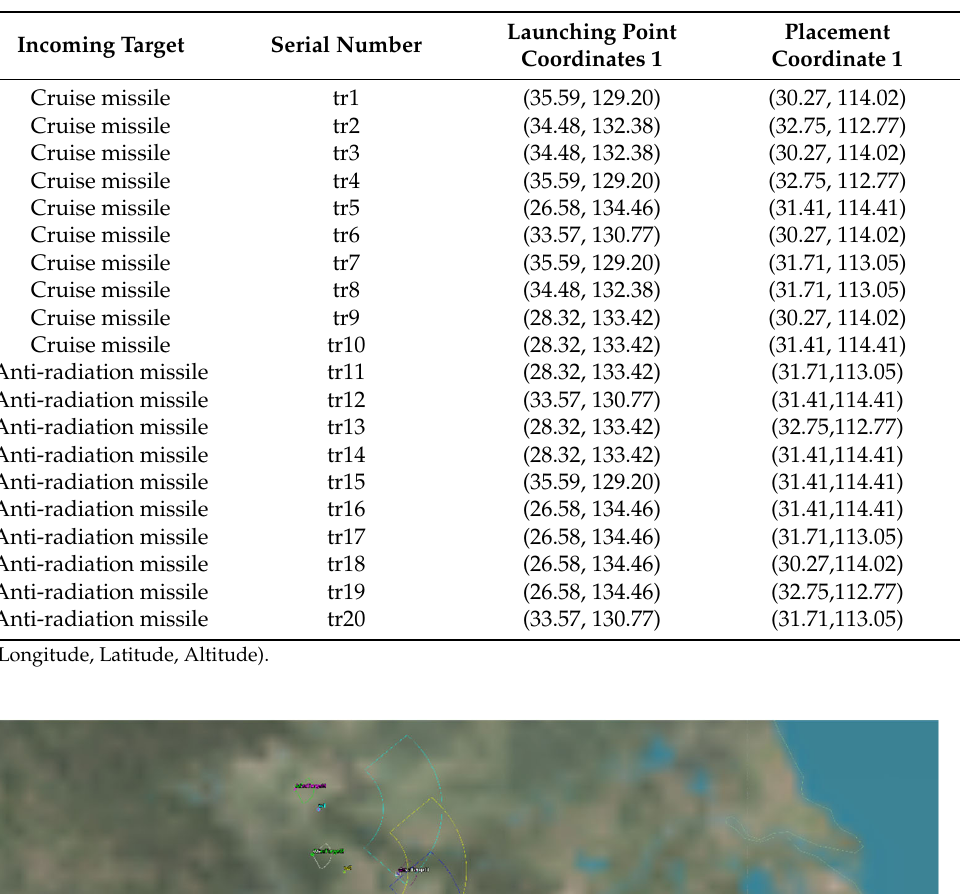
Figure 5. 3D schematic diagram of operational scenarios. Firstly, preprocess the data to obtain the intercept sequence of the combat unit to the incoming target, the result is shown in Figure 6. Figure 6. Sequence diagram of incoming target interception.